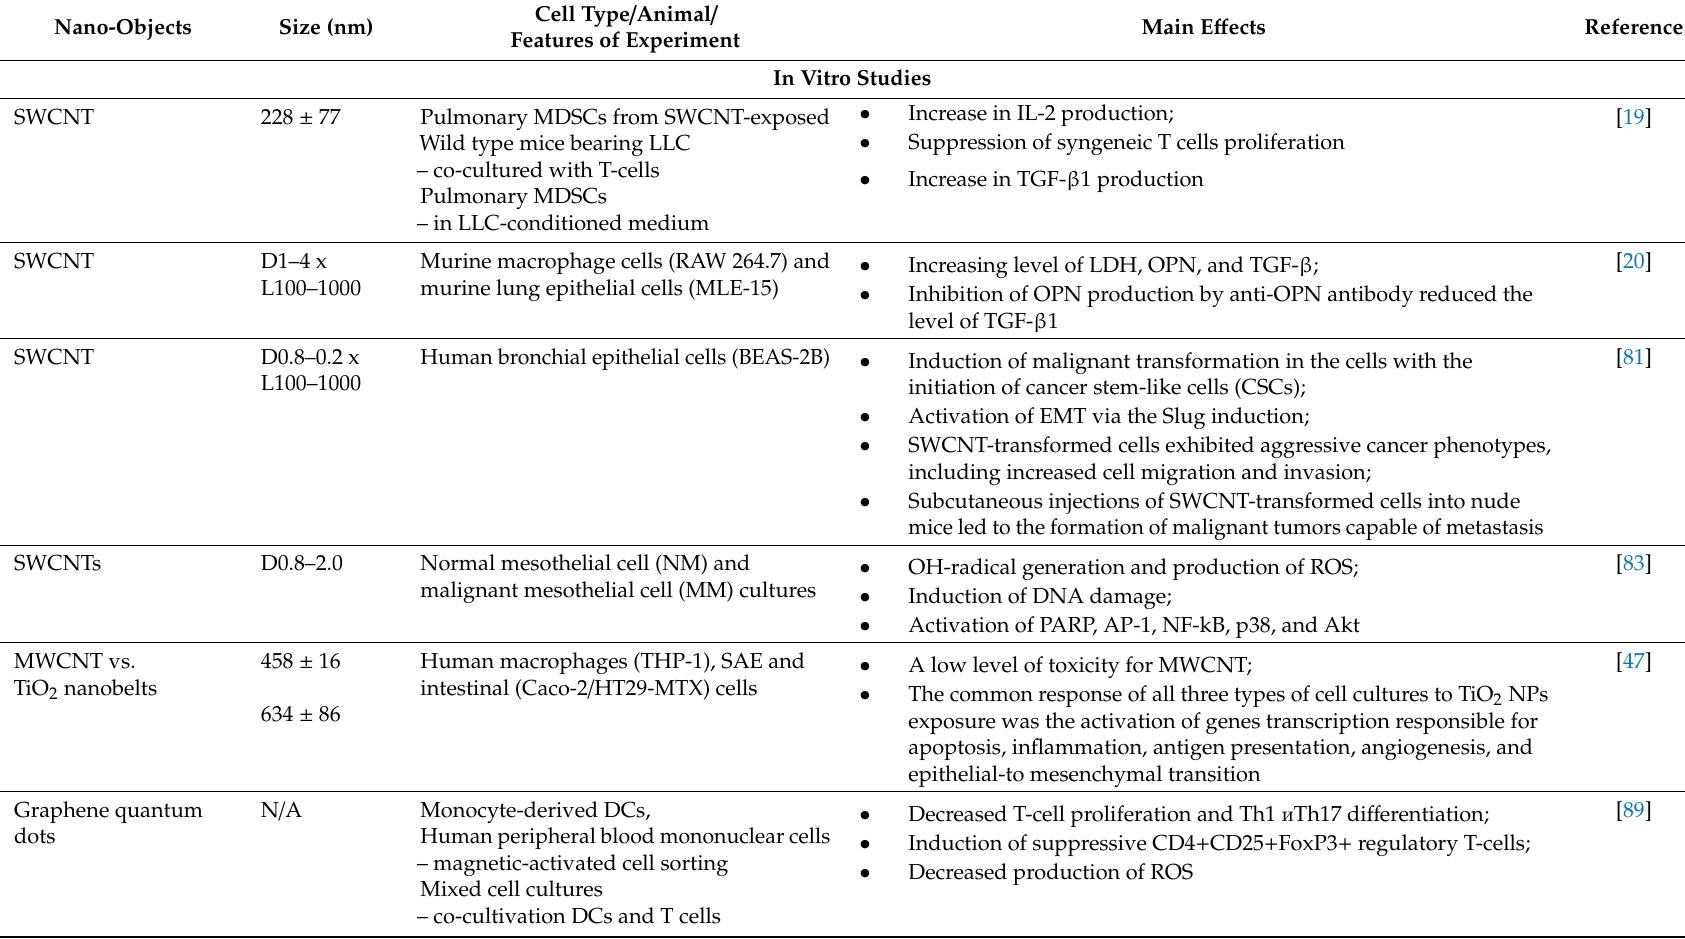
Table 1. The main pro-carcinogenic e ff ects of di ff erent types of